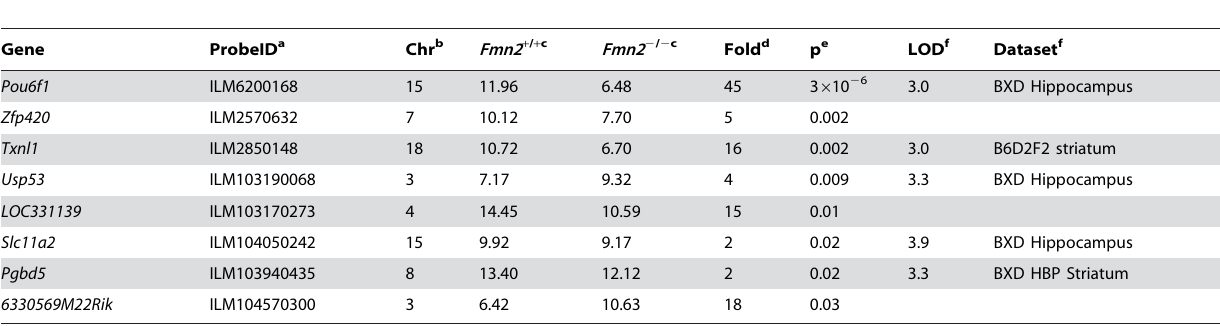
Table 6. Genes that have significant expression difference between Fmn2 + / + and Fmn2 2 / 2 .